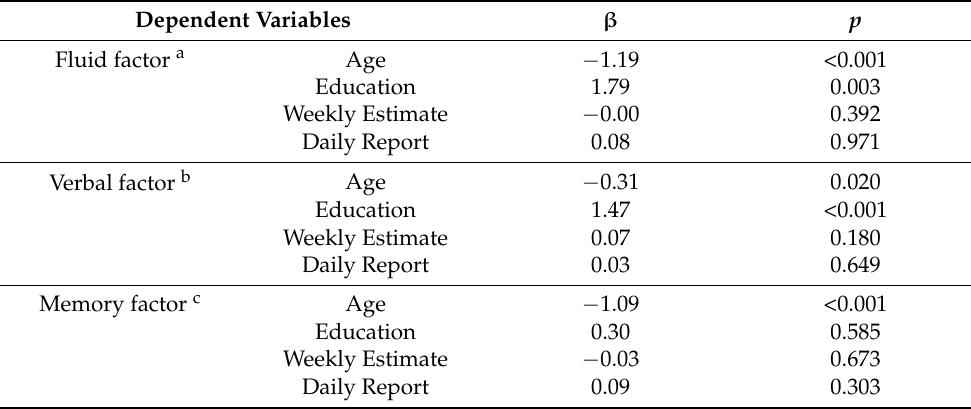
Table 3. Multivariate Multiple Regression Standardized Coefficients for Total Activity, Age, and Education Predicting Cognitive